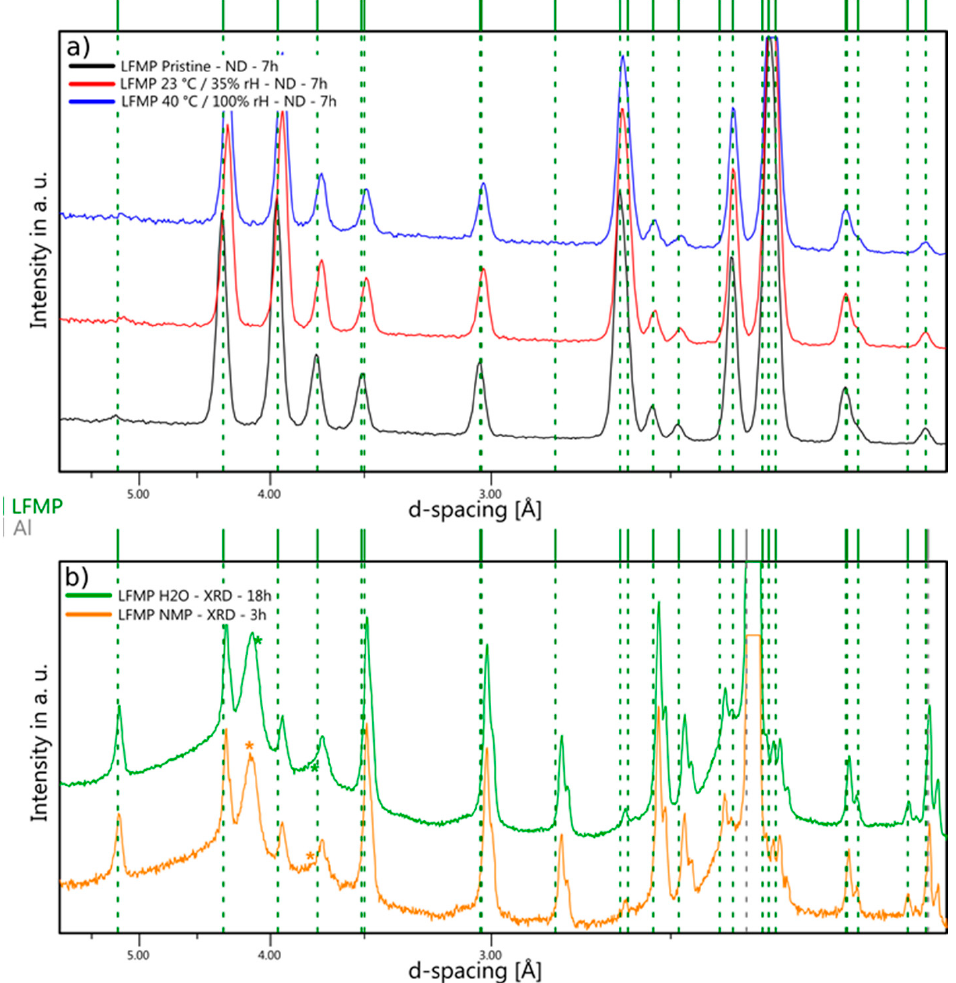
Figure 2. Comparison of the neutron and X-ray diffraction patterns of studied LFP samples. ( a ) Neutron diffraction data of pristine and aged LFMP-powders ( λ = 1.5482 Å); ( b ) X-ray diffraction patterns